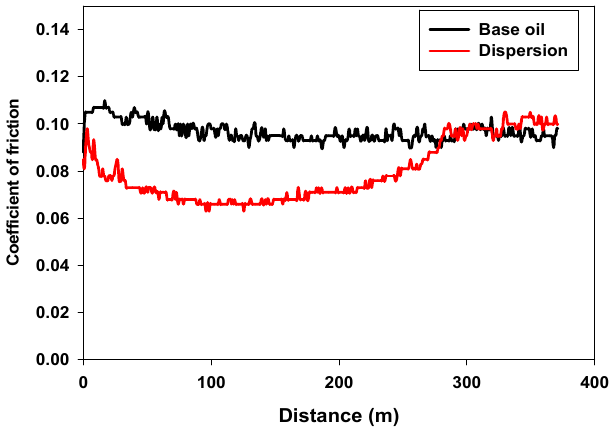
Figure 7. Variation of coefficient of friction (COF) with sliding distance for the base oil ( black ) and the dispersion ( red ).